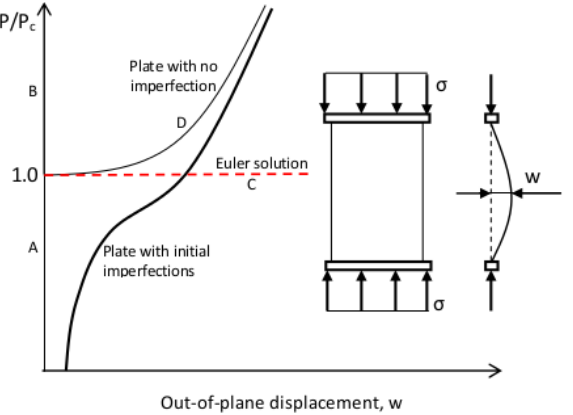
Figure 1: The influence of initial plate imperfections on buckling behaviour of a plate (following [30]).